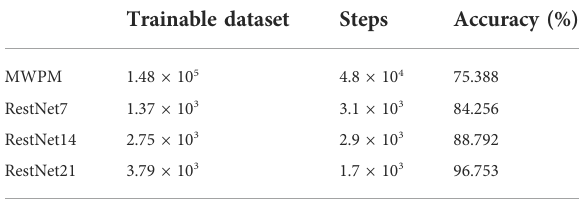
TABLE 1 Uni fi ed quantization of network layers under different